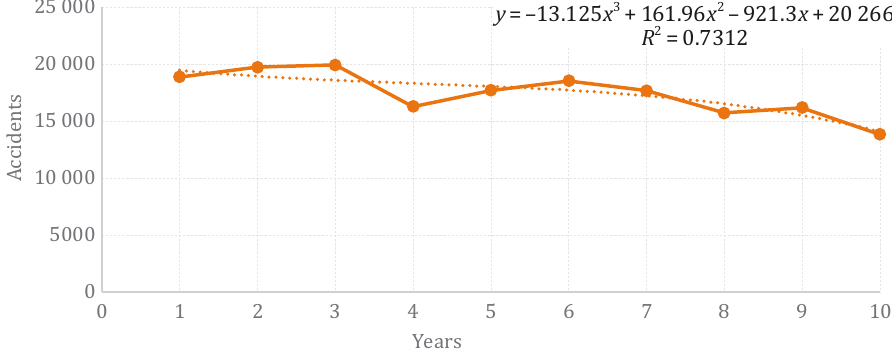
Figure 6. Number of accidents for the period of 2011–2020 associated with a polynomial trend of the 3 rd order